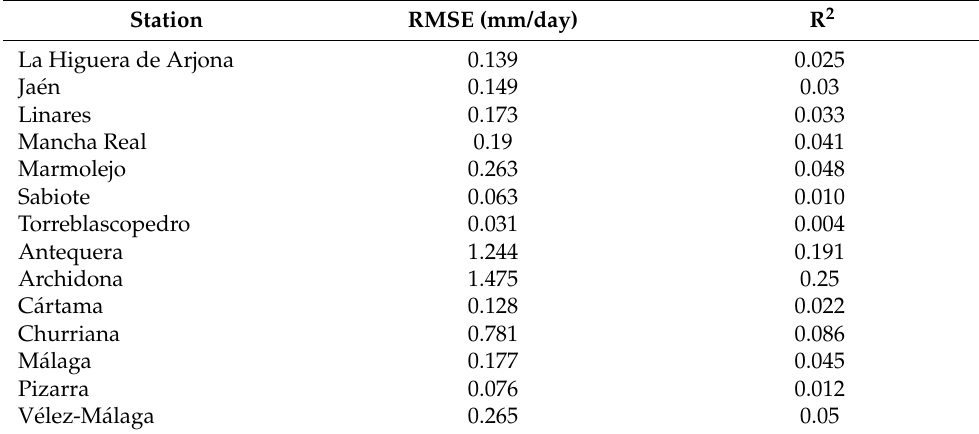
Table 8. Best improvements between simple arithmetic averaging and the best ML model from each site for R 2 and RMSE. A positive value means that ML outperformed LI.